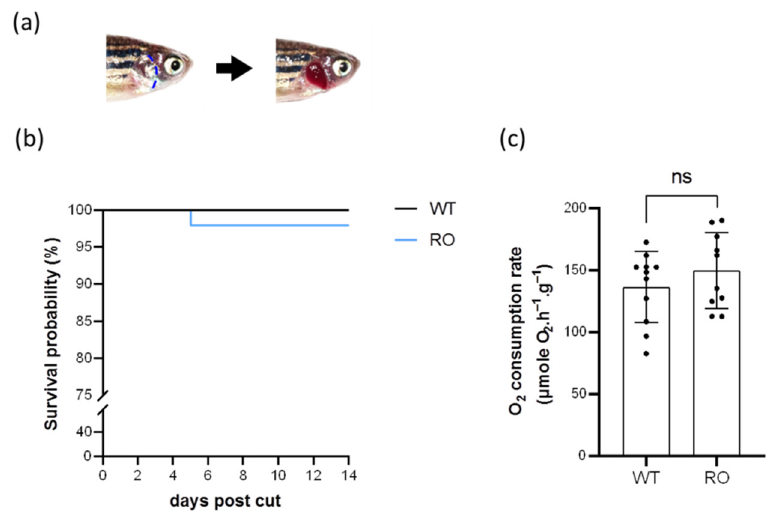
Figure 1. Effects of removal of the opercula on the survival rate and oxygen consumption rate. The opercula were cut along the blue dashed line, and the schema of opercula-removed zebrafish is shown ( a ). The survival rate (N = 50) ( b ) and oxygen consumption rate (N = 10–11) ( c ) were recorded after the opercula were removed. Values are the mean ± SD. Student’s t -test. ns = not significant. WT = wild type. RO = removal of the